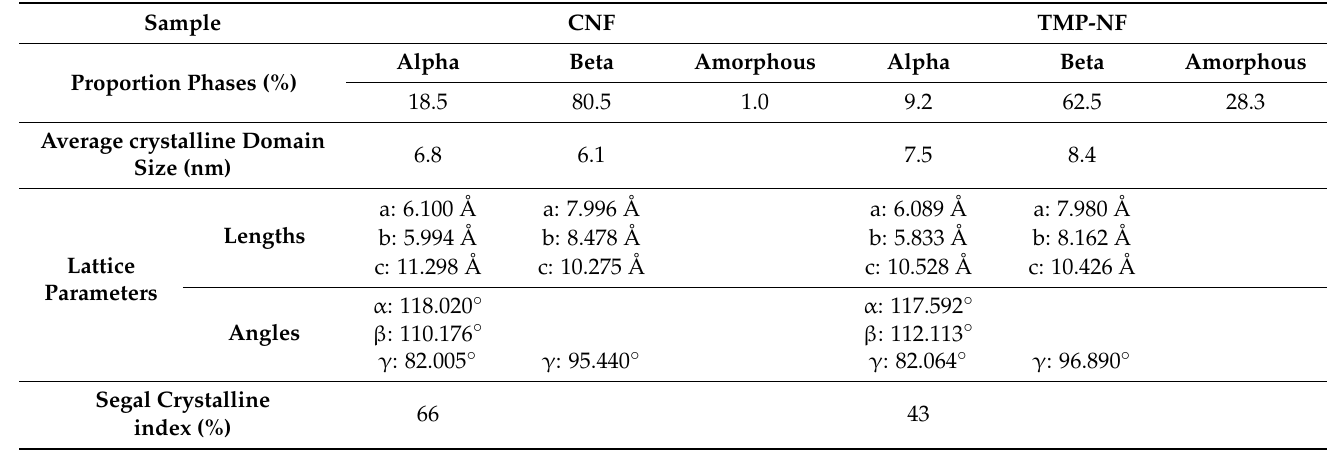
Figure 8. FTIR-ATR analysis. Spectra for the CNF and TMP-NF samples. Table 2. Results of XRD Analysis for CNF and TMP-NF using TOPAS